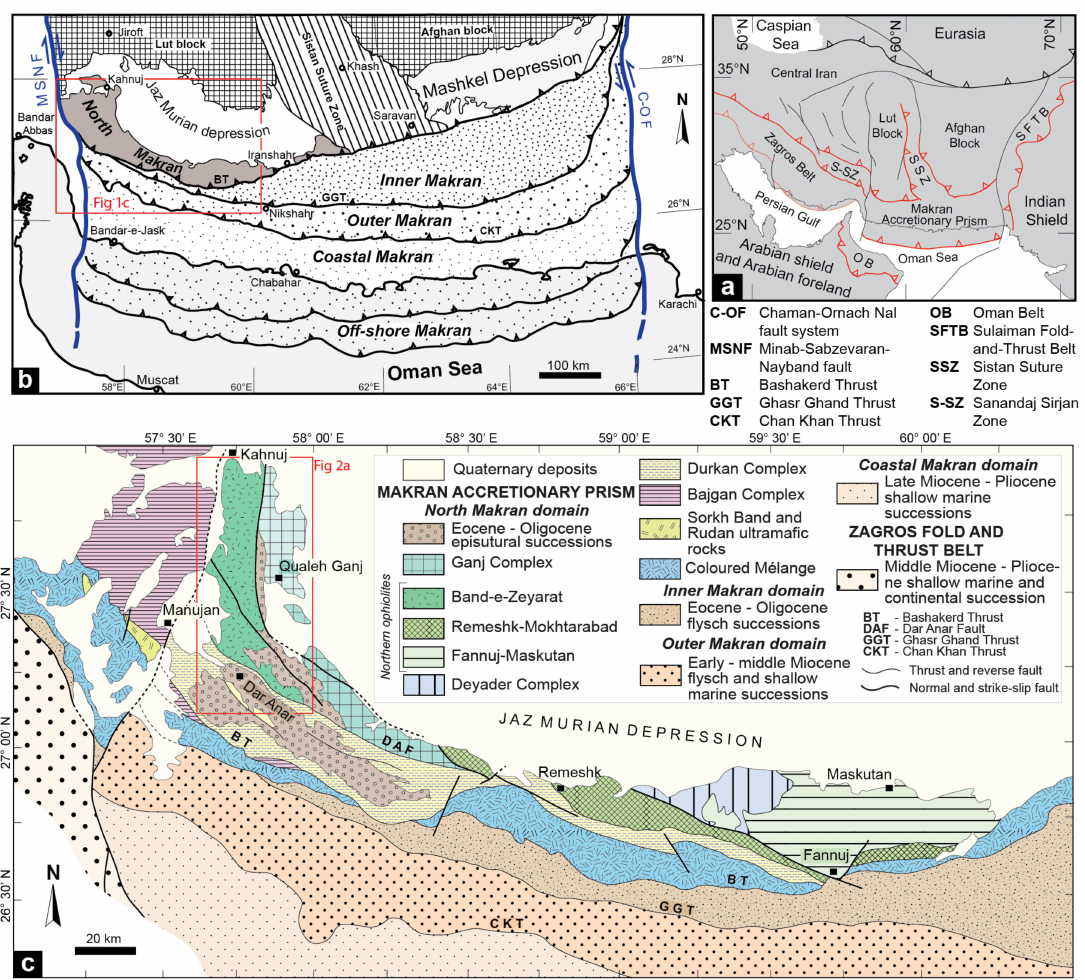
Figure 1. Tectonic sketch map of the Middle East area ( a ) showing the main tectonic plates and convergent zones (modified from Bagheri and Stampfli [32]; Zanchetta et al. [33]; Mohammadi et al. [34]; Pirnia et al. [35]; Barbero et al. [23]). ( b ) Simplified structural map of the Makran Accretionary Wedge (modified from Burg et al. [13]), ( c ) simplified geological-structural map of the North Makran Domain showing the di ff erent tectonic units (modified from Eftekhar-Nezhad et al. [36]; Samimi Namin [37,38]; Hunziker et al. [15]; Burg [16]; Barbero et al.